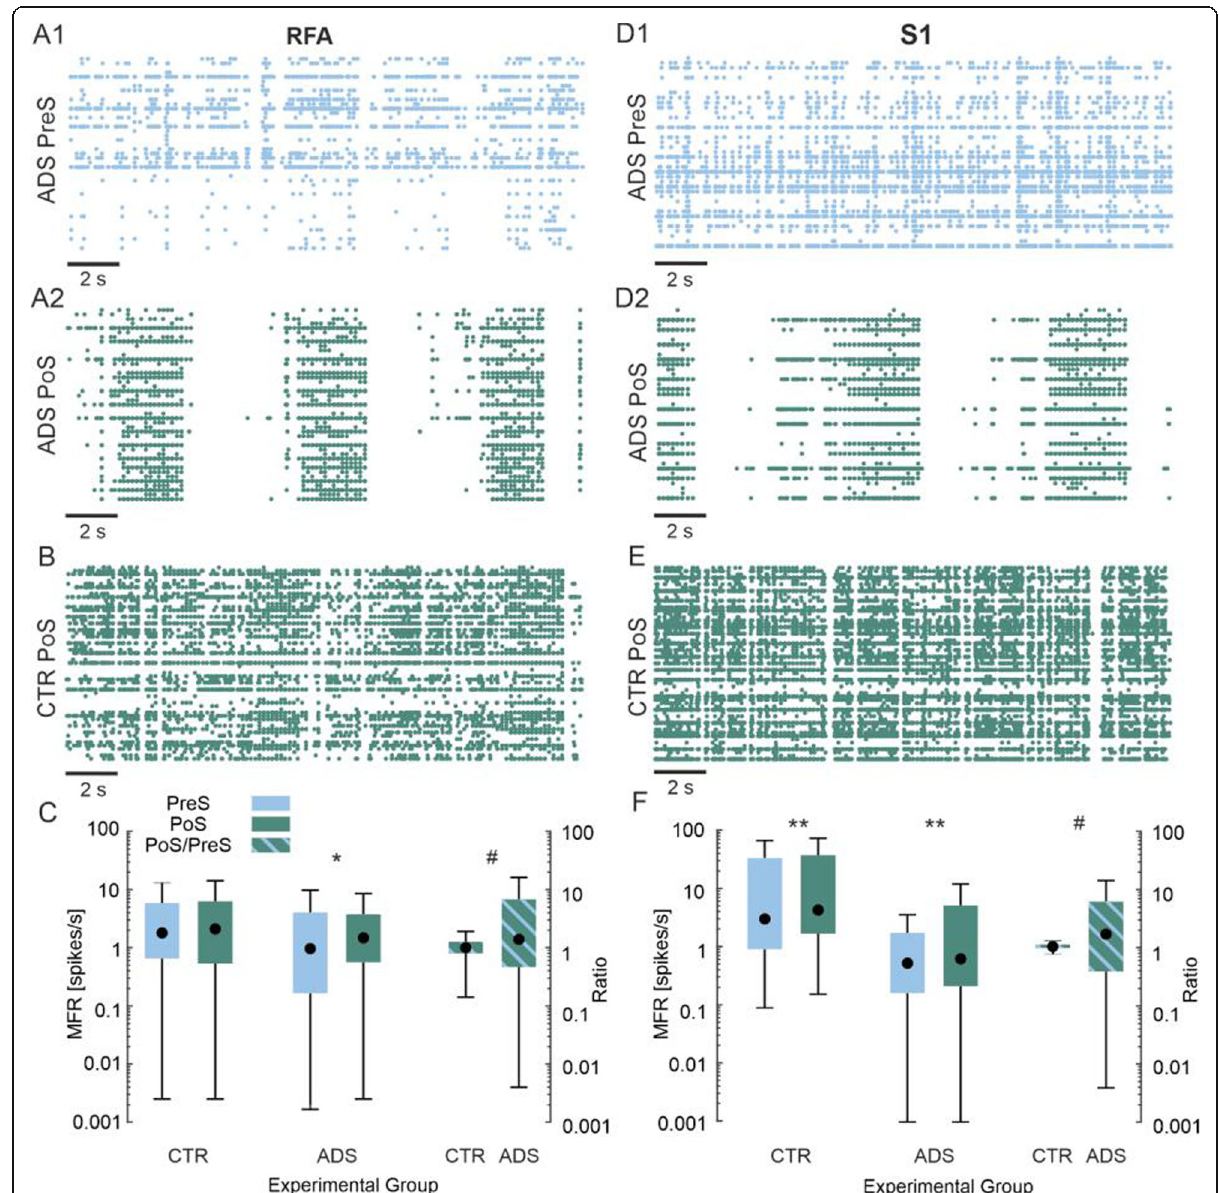
Fig. 4 Effect of the stimulation on the firing rate: ADS vs CTR. A) 20-s raster plots of the activity recorded in RFA in a representative Activity- Dependent Stimulation (ADS) experiment: Pre Stim phase - PreS ( A1 ) and Post Stim phase - PoS ( A2 ). B) 20-s raster plot of the activity recorded in RFA in a representative Control (CTR) experiment: Post Stim phase - PoS ( B ). C) Box plot of the Mean Firing Rate (MFR, spikes/s) of RFA for the entire dataset of CTR and ADS experiments. D) A 20-s raster plot of the activity recorded in S1 in a representative Activity-Dependent Stimulation (ADS) experiment: Pre Stim phase - PreS ( D1 ) and Post Stim phase - PoS ( D2 ). E) A 20-s raster plot of the activity recorded in S1 in a representative Control (CTR) experiment: Post Stim phase - PoS ( E ). F) Box plot of the Mean Firing Rate (MFR, spikes/s) of S1 for the entire dataset of CTR and ADS experiments. For each box plot ( C- F ), the central black dot indicates the median, the box limits indicate the 25th and 75th percentiles. Whiskers represent the 5th and the 95th percentiles. * p < 8·10 − 3 , ** p < 8·10 − 5 Wilcoxon signed rank test; # p < 8·10 − 3 Wilcoxon rank- sum test. Color code as in Fig.